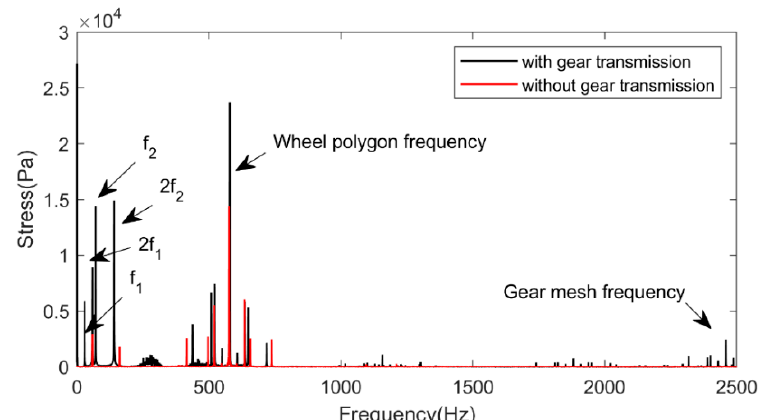
Figure 16. Spectra of the stress of the gearbox housing considering gear transmission.